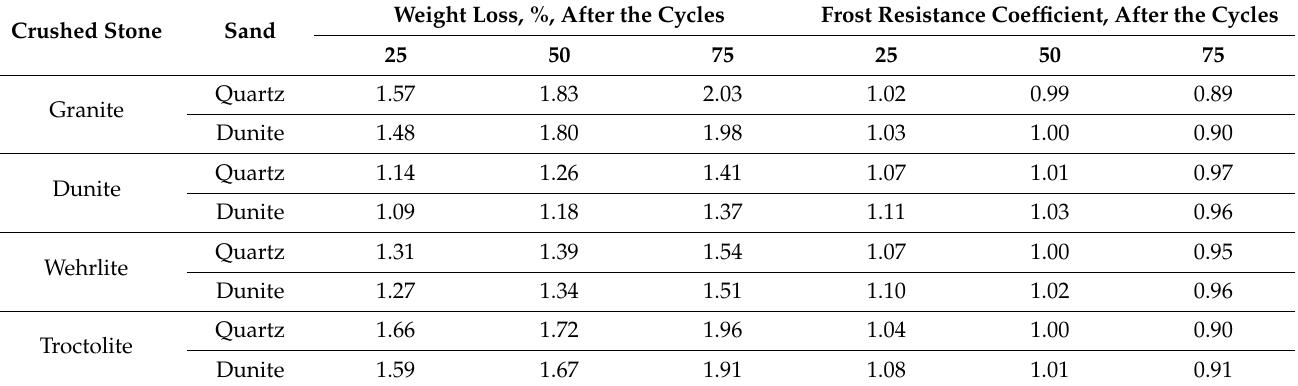
Table 6. Concrete frost resistance